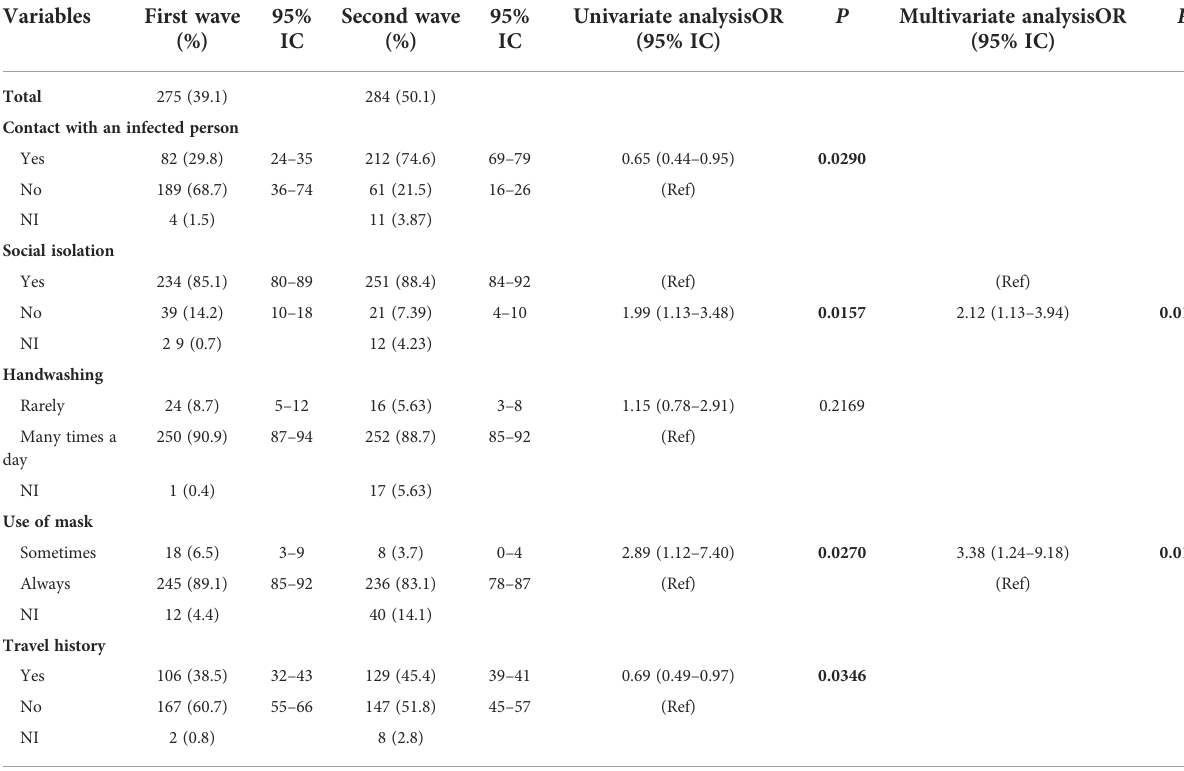
TABLE 2 Seropositivity associated with behavioral characteristics after the fi rst and second waves of COVID-19.